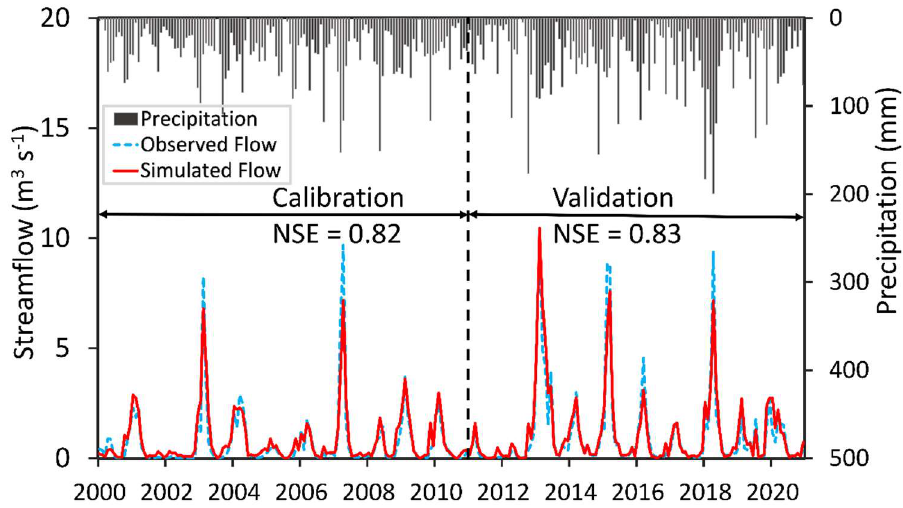
Figure 2. Observed and simulated average monthly streamflow and precipitation at the Olite gauging station from 2000 to 2020.